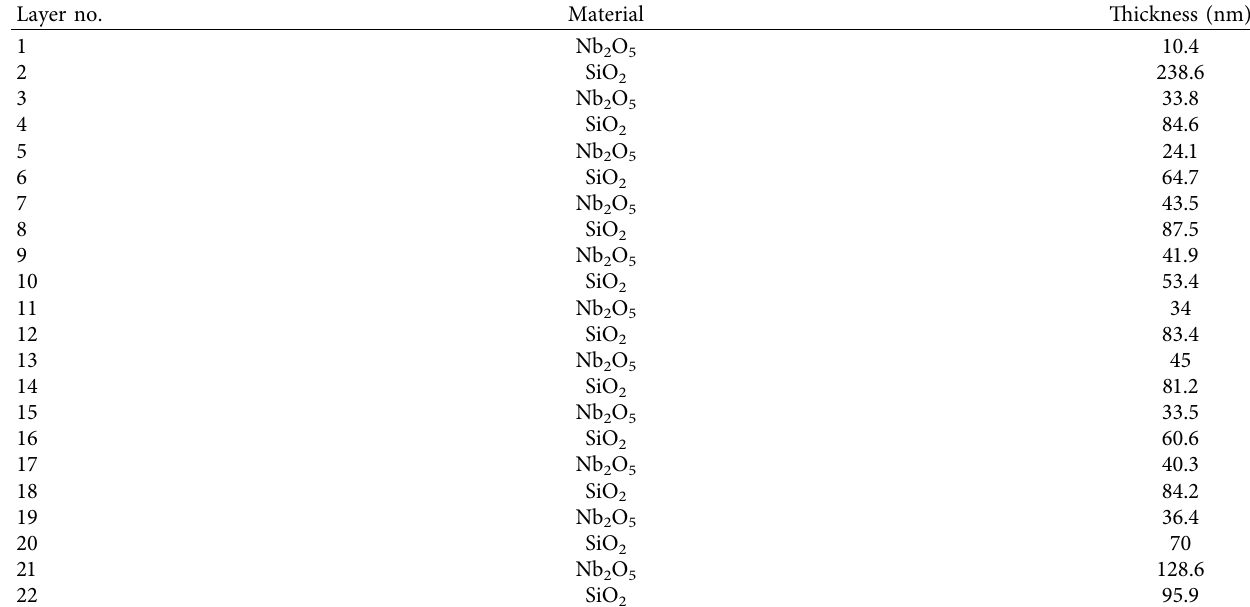
Figure 2: Calculated optical properties of sputtered SiO Table 6: Material thicknesses (T.) of the quarter-wave bandpass flter design [22]. Layer